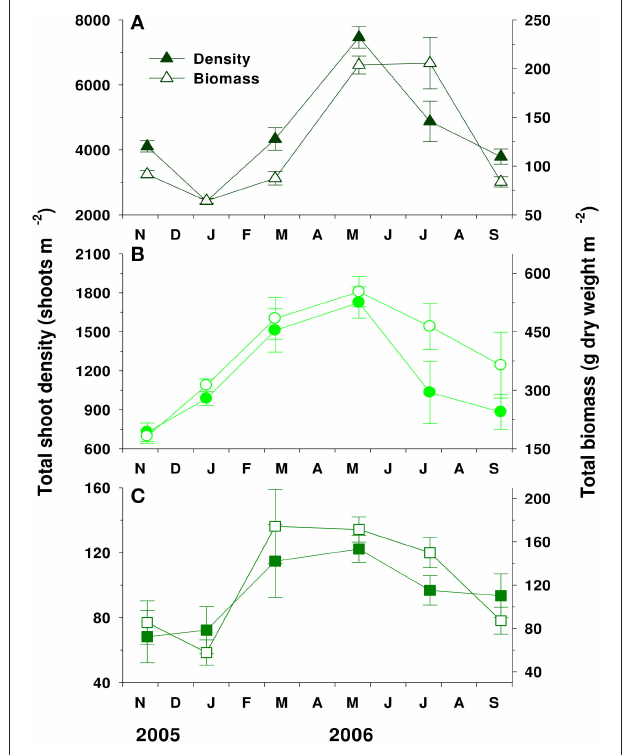
FIGURE 5 | Seasonal variations in the total shoot density and total biomass of Zostera japonica (A) , Zostera marina (B) , and Zostera caespitosa (C) in Koje Bay. Values are expressed as mean ± SE ( n =